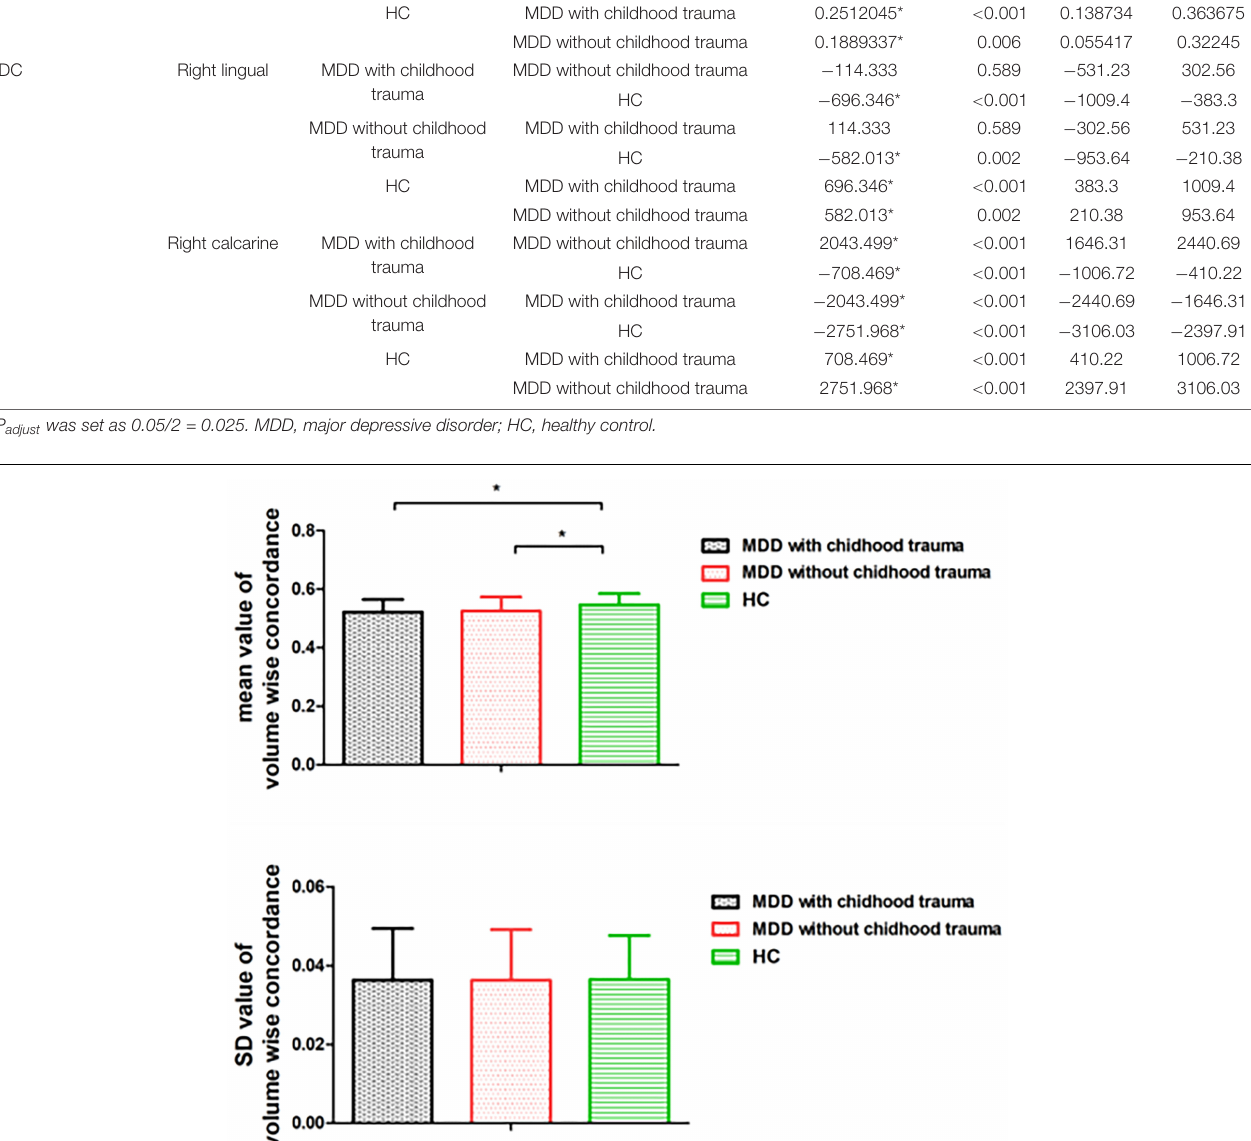
education were considered as nuisance covariates. To avoid multicollinearity, we performed mean centering for all the independent variables before constructing the interaction terms (Holmbeck, 1997). As shown in Table 8 , further